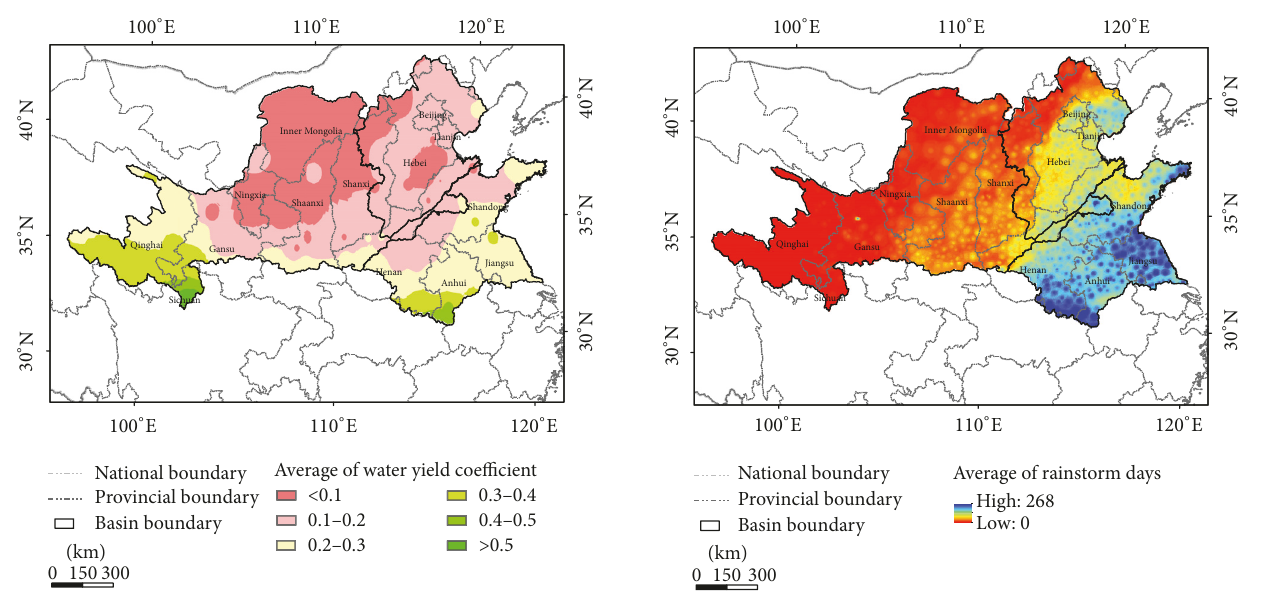
Figure 21: The spatial distribution of multiyear average rainstorm days from 1982 to 2011.